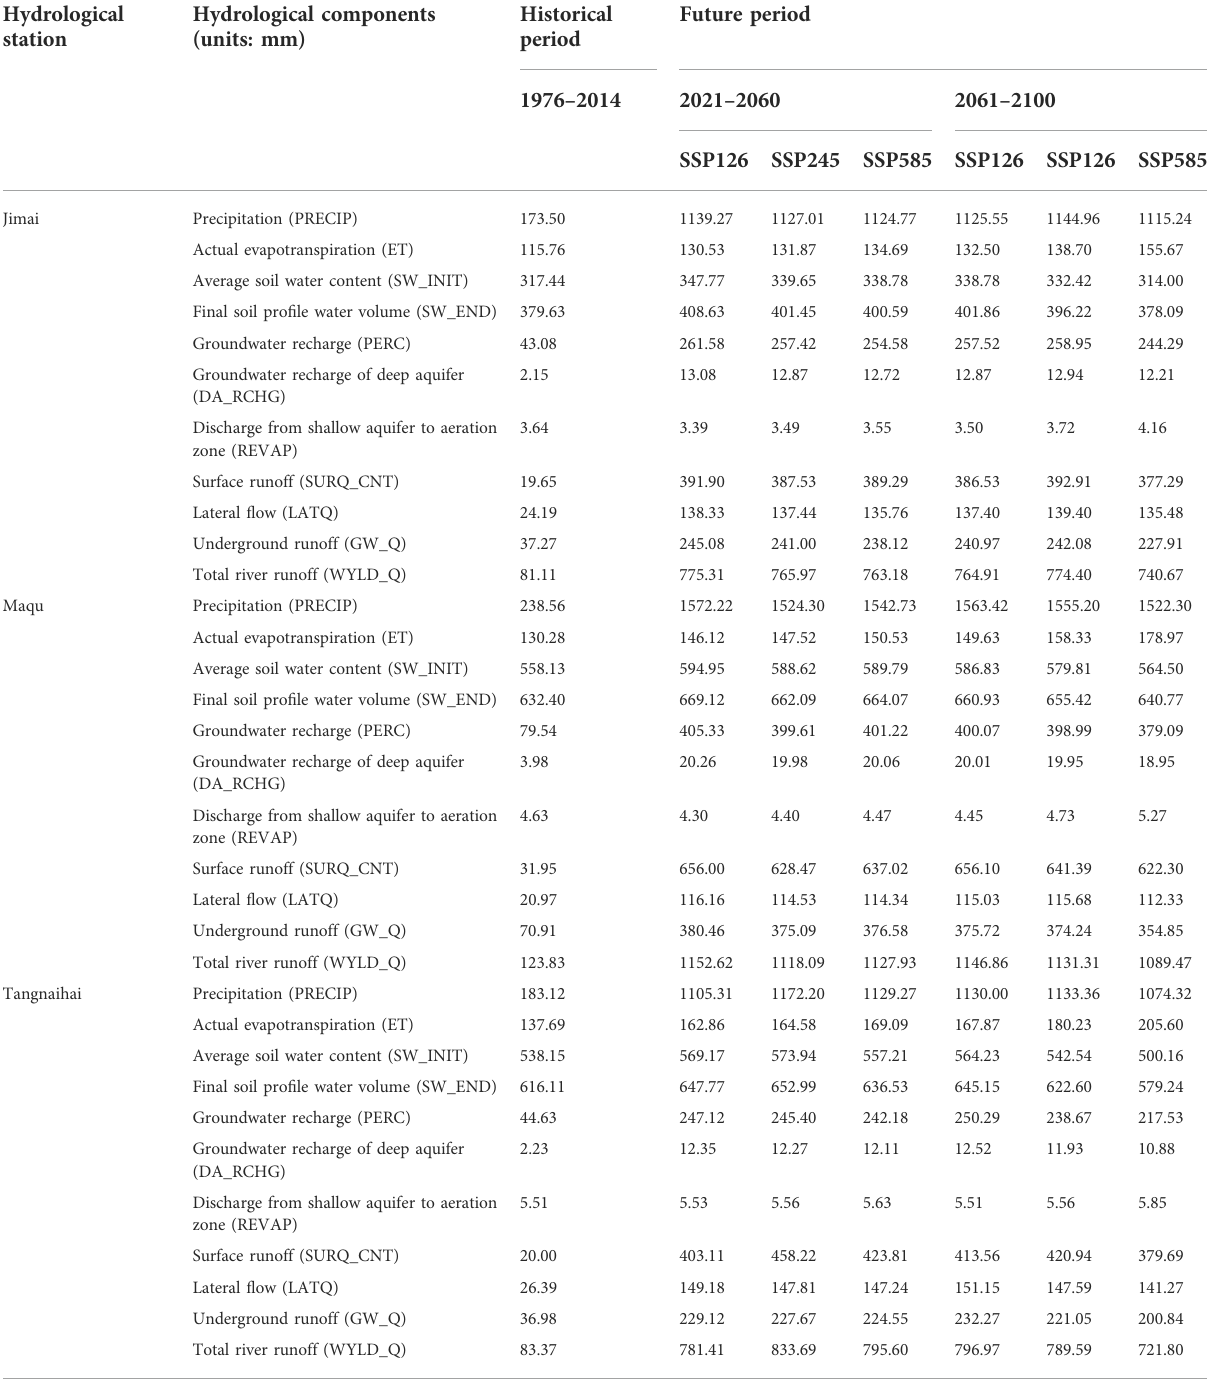
TABLE 7 Hydrological components of three hydrological stations in historical and future